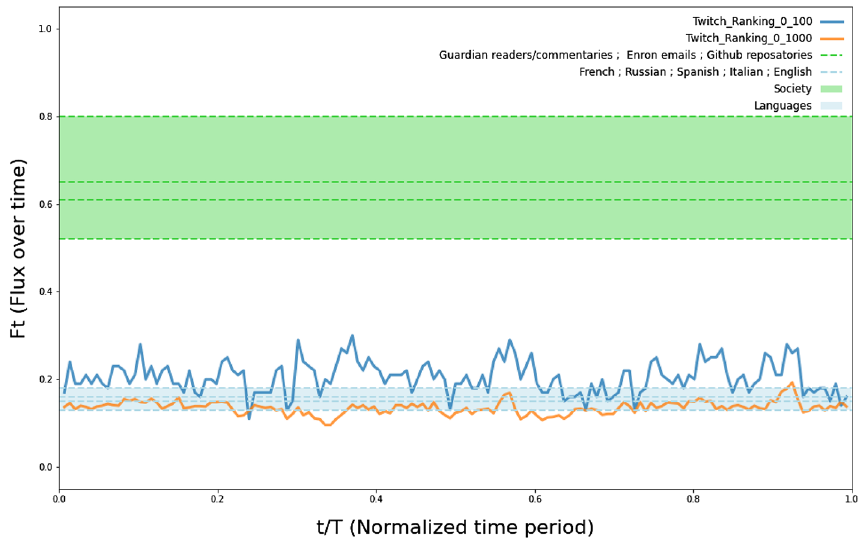
Figure 6. Time flux (Ft) plot over normalized time period (t/T) for Twitch (solid lines) and parameters from original study (bands, dashed lines): Flux defined as the probability that an element present in the list at T0 leaves at T1 over normalized time period: Twitch top 100: F ≈ 0.2; Twitch top 1000: F ≈ 0.135; Society datasets (Guardian readers: F ≈ 0.80; Github repositories: F ≈ 0.65; Guardian commentaries: F ≈ 0.61; Enron emails: F ≈ 0.52); Language (word usage) datasets (French: F ≈ 0.18; Russian: F ≈ 0.18; Spanish: F ≈ 0.16; Italian: F ≈ 0.15; English: F ≈ 0.13). This shows that the Twitch ranking dynamics resemble that of more relatively stable datasets such as language related ones rather than more variable, social systems related